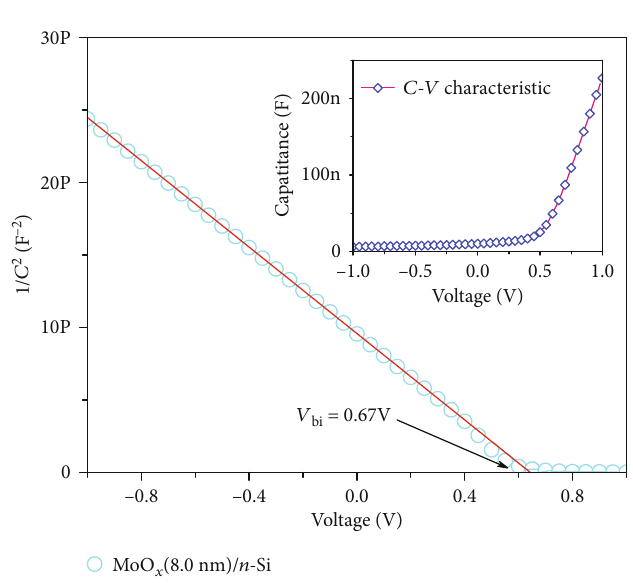
Figure 5: 1/ C 2 versus voltage plot of the MoO